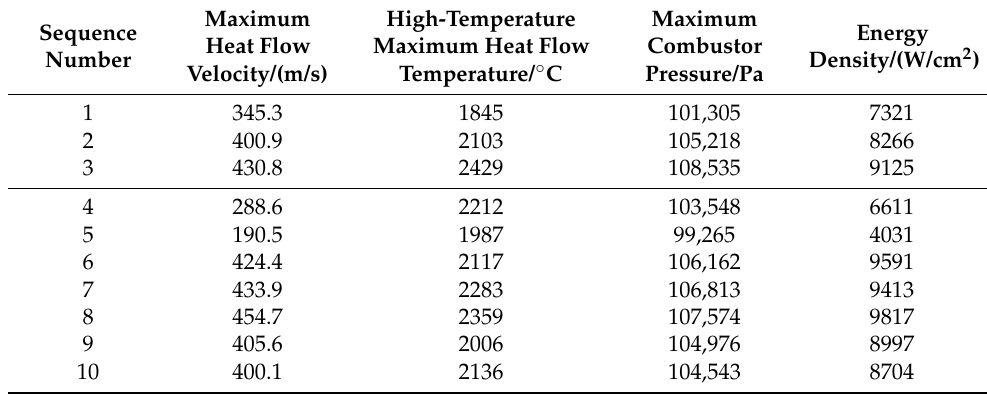
Table 1. Performance parameters of high-temperature heat flow.